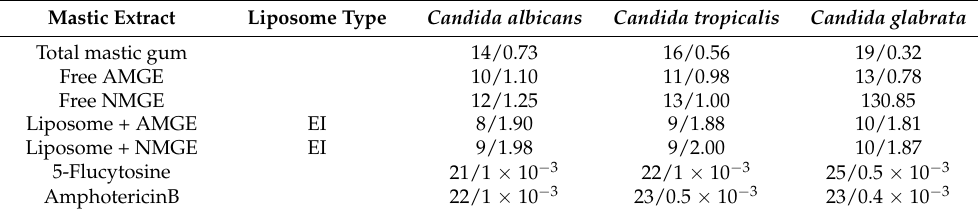
Table 3. Antifungal activity (inhibition zone and MIC mg/mL) of mastic extracts before and after liposome encapsulation.